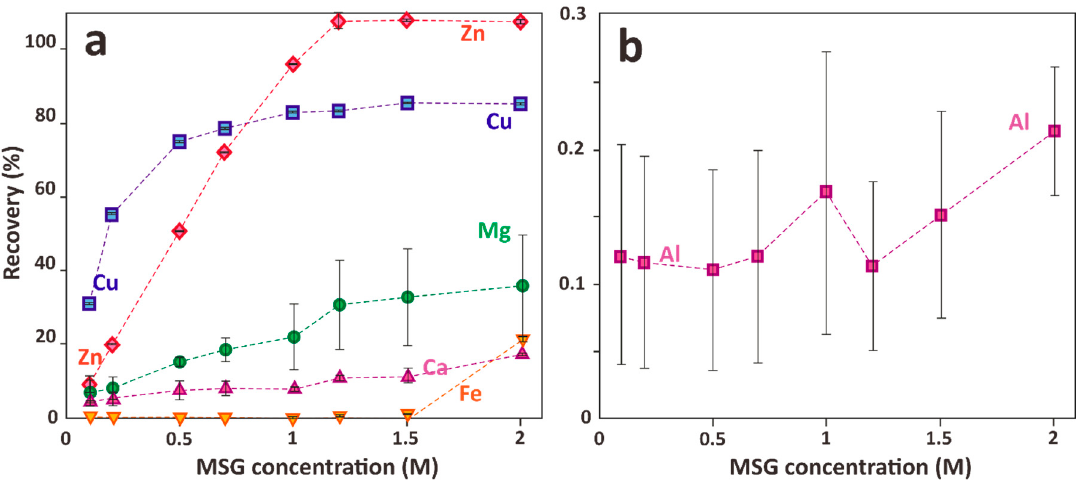
Figure 6. The recovery of ( a ) Zn, Cu, Mg, Ca and Fe and ( b ) Al as function of MSG concentration.